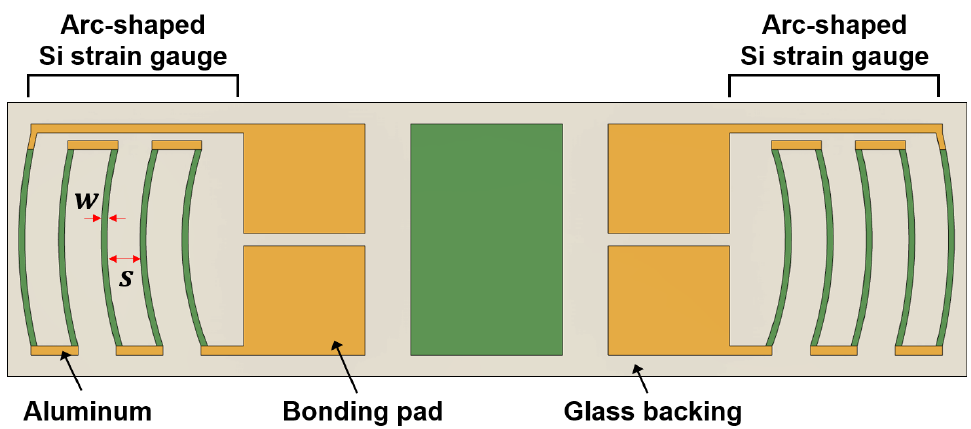
Figure 4. A newly designed tangential strain gauge chip and its design parameters.